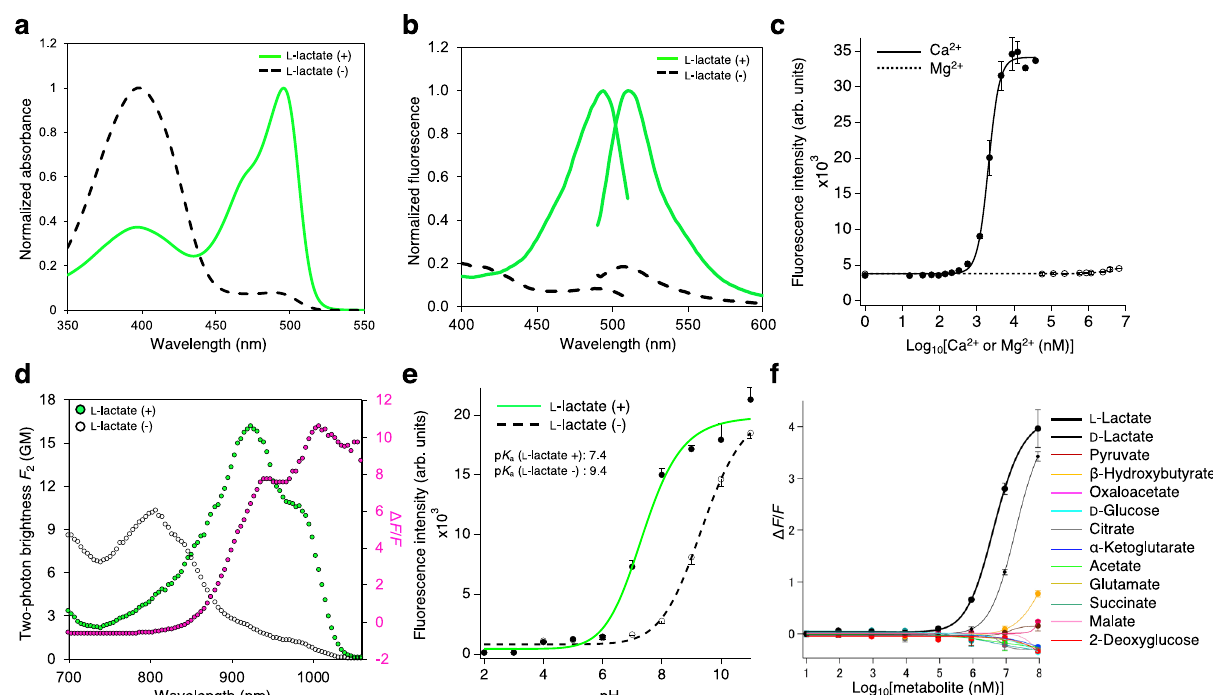
Fig. 2 In vitro characterization of af fi nity-tuned eLACCO1.1. a Absorbance spectra of eLACCO1.1 in the presence (100 mM) and absence of L -lactate. b Excitation and emission spectra of eLACCO1.1 in the presence (100 mM) and absence of L -lactate. c Fluorescence of eLACCO1.1 in the presence of 100 mM L -lactate as a function of Ca 2 + and Mg 2 + . N = 3 independent experiments (mean ± s.d.). d Two-photon excitation spectra of eLACCO1.1 in the presence (100 mM) and absence of L -lactate. Δ F / F is represented in magenta. GM Goeppert-Mayer units. e pH titration curves of eLACCO1.1 in the presence and absence of 100 mM L -lactate. n = 3 independent experiments (mean ± s.d.). f Dose-response curves of eLACCO1.1 for L -lactate and a variety of metabolites. n = 3 independent experiments (mean ± s.d.). Source data are provided as a Source Data fi le.